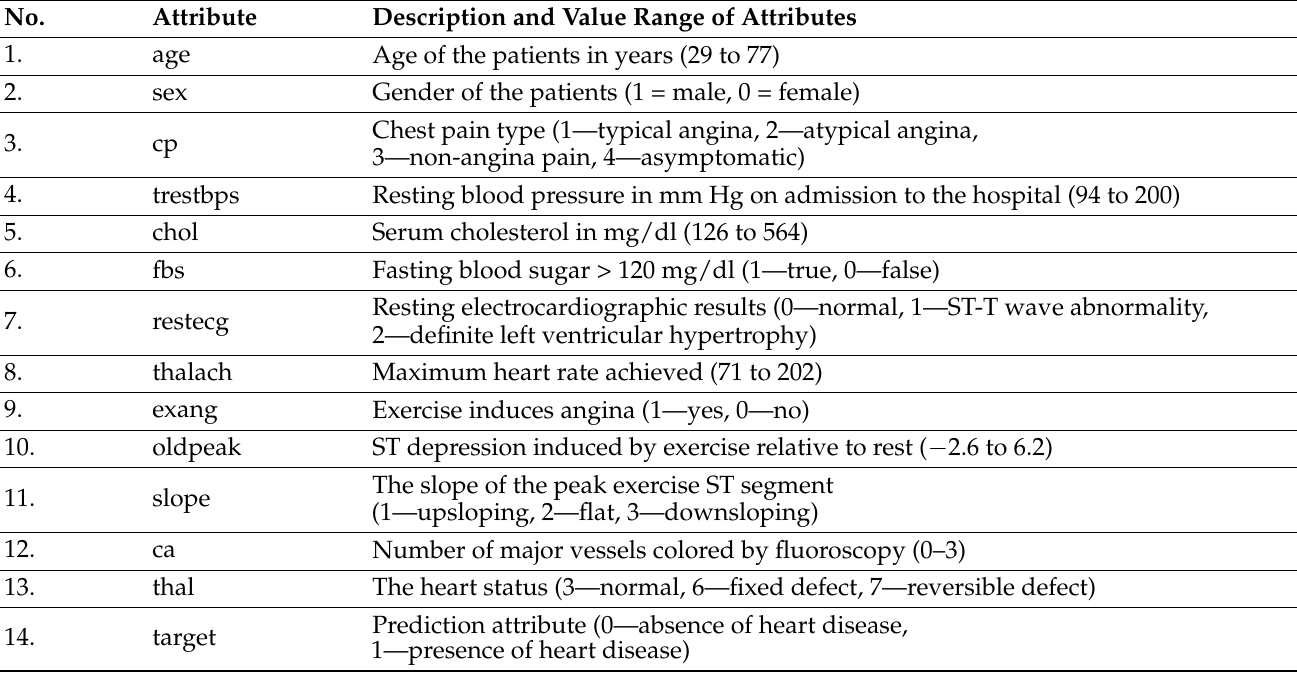
Table 3. Description and value range of combined heart dataset